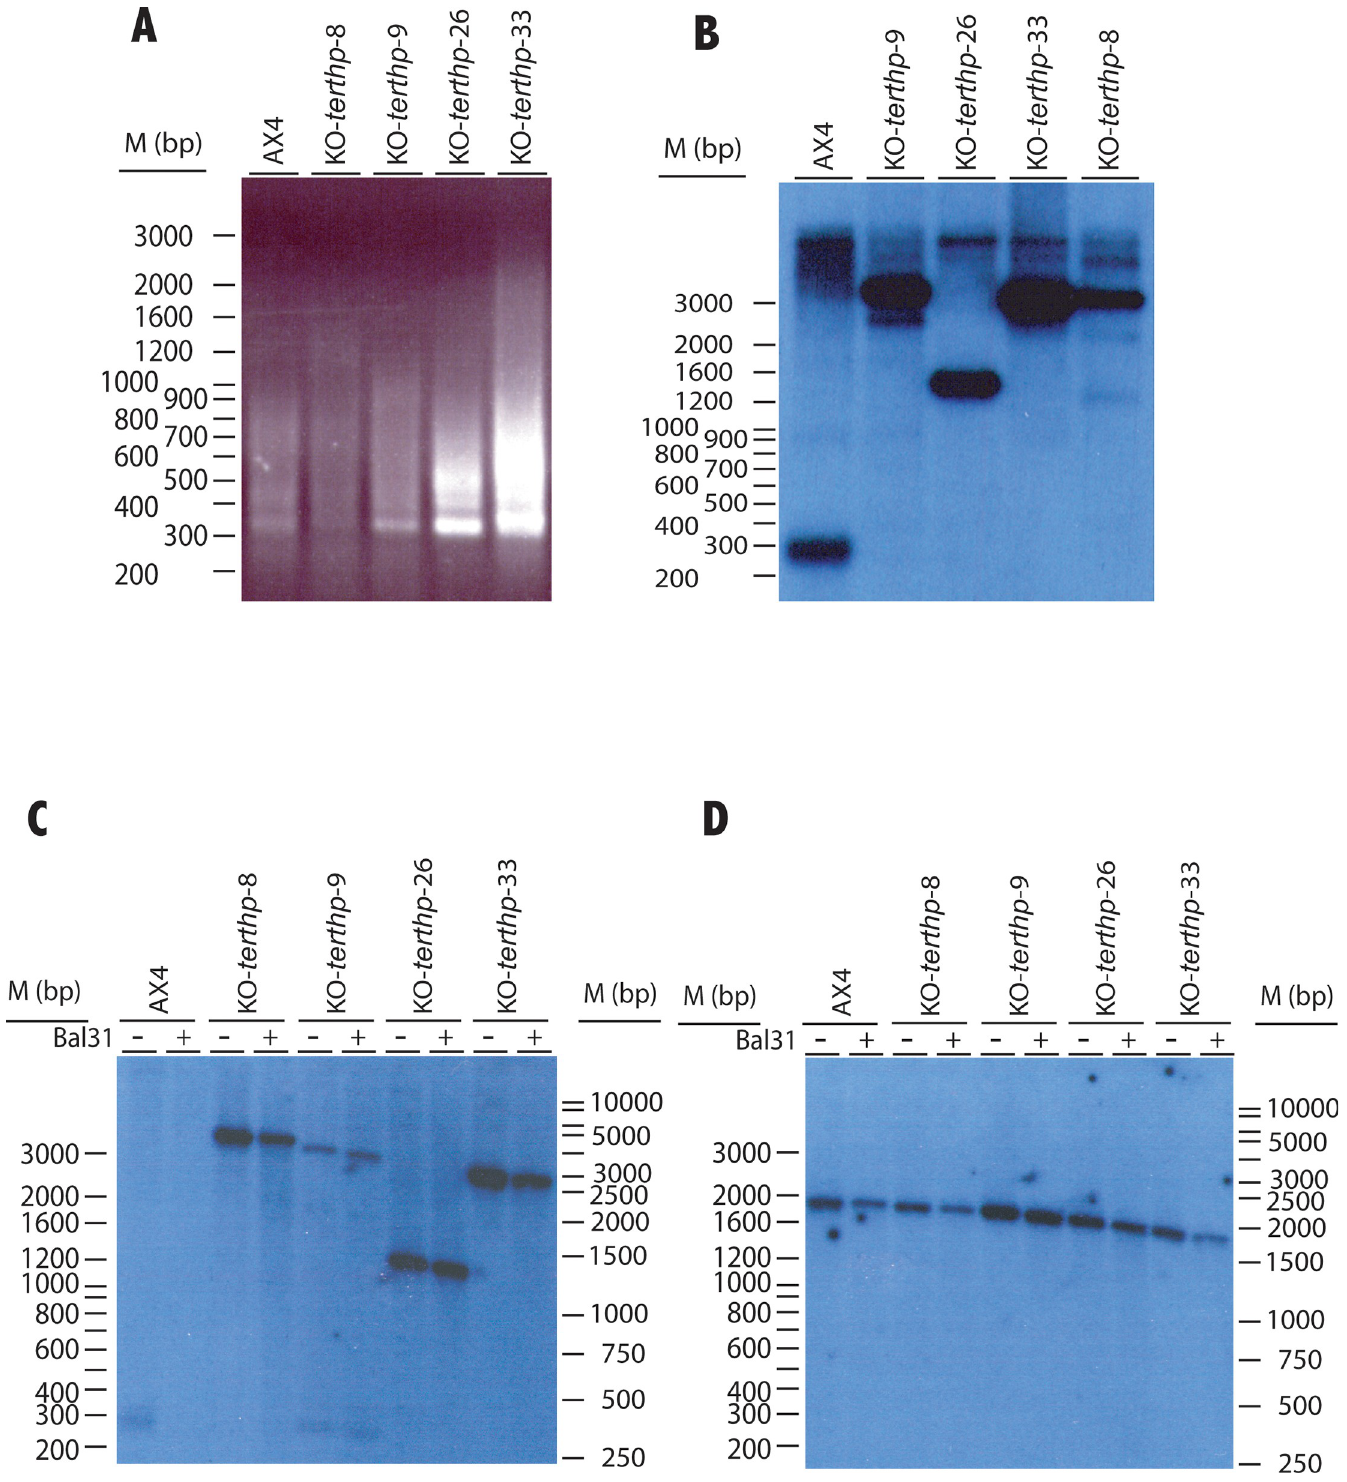
Fig 6. Determination of telomere structure in KO- terthp mutant strains. Panel A. Analyses of the size of the region containing A(G) n repeats by PCR. Total DNA was isolated from the wild type (AX4) and terthp -mutant (KO- terthp -8, KO- terthp -9, KO- terthp -26 and KO- terthp -33) strains after 25 generations of growth and amplified by PCR using the same oligonucleotides described in Fig 1. Panel B. Southern blot analyses of total DNA digested with the NheI restriction enzyme and hybridized with a oligonucleotide probe complementary to the A(G)n repeats. Lanes are labelled as in panel A. Panels C and D. DNAs isolated from each strain were digested with 2